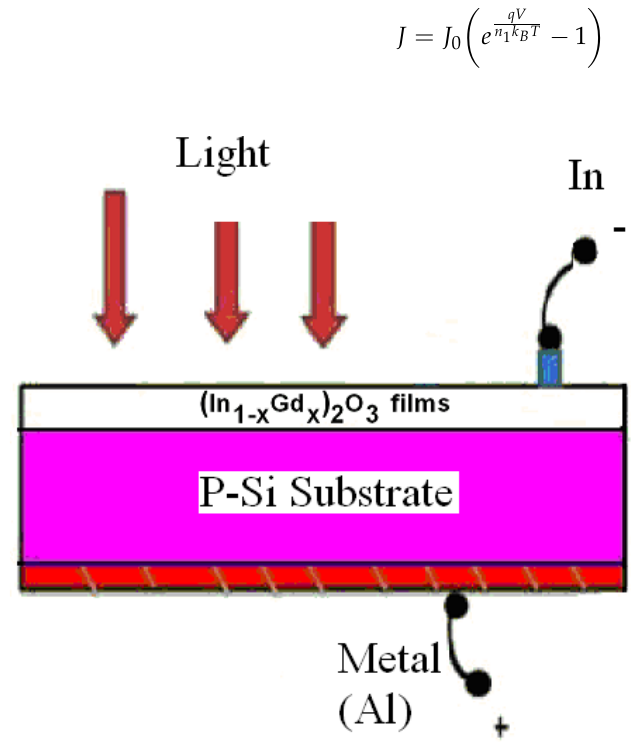
Figure 13. The diagram of studied p-n junction n- (In 1 − x Gd x ) 2 O 3 films / p-Si substrate. The electronic charge that equals ( 1.6 × 10 − 19 C ) and evaluates the Boltzmann’s constant k B in this equation at room temperature (RT) represents the saturation current density and typifies the quality factor of the manufactured